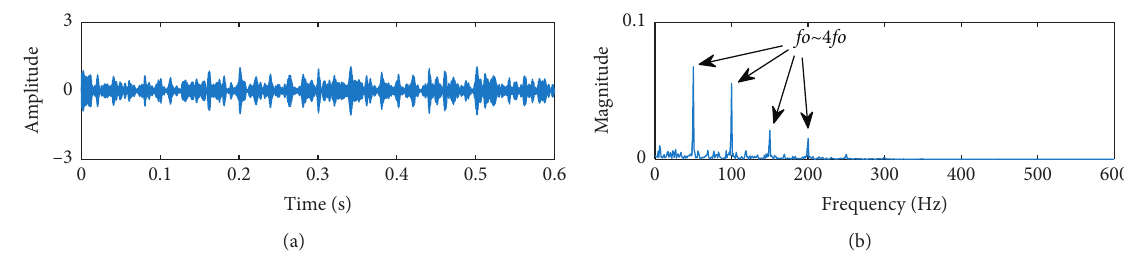
Figure 7: (a) Time-domain waveform and (b) 1.5D spectrum of the optimal